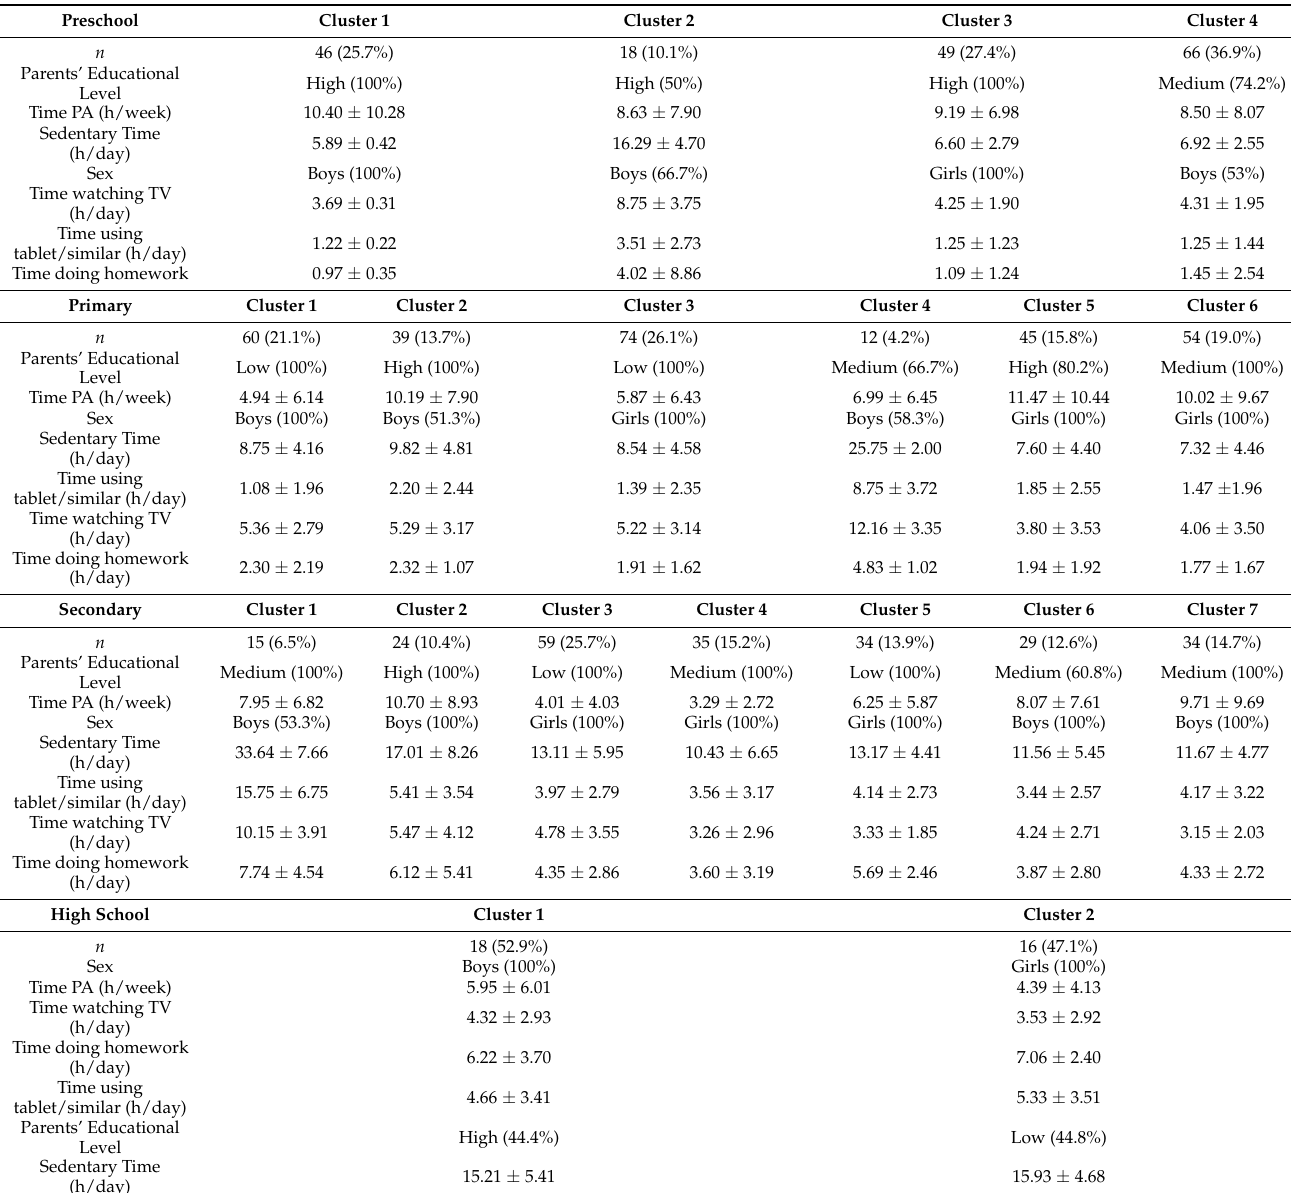
Table 1. Results of the age stage groups (clusters) identified by the two-step cluster analysis for infantile, primary, secondary and high